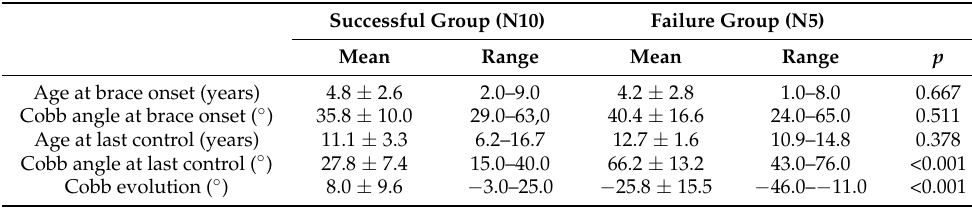
Table 3. Patients under 5 years at diagnosis. Cobb evolution in both successful and failure groups ( p <